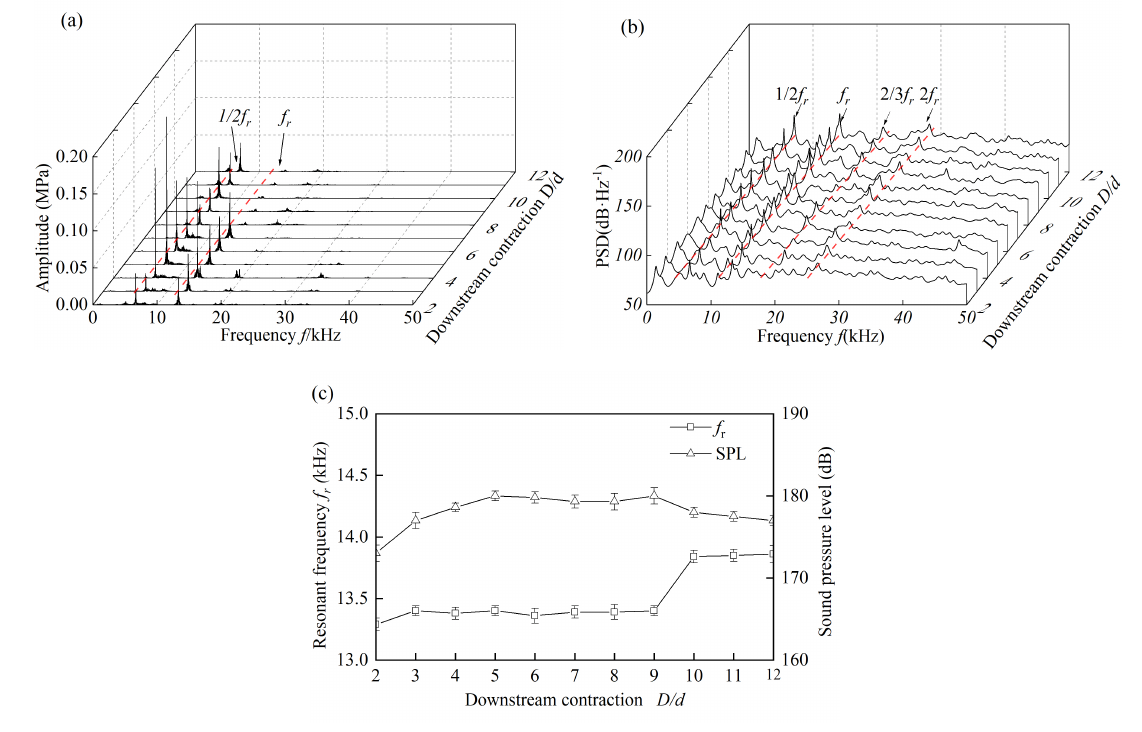
Figure 7. Frequency characteristics of self-excited waterjet as a function of downstream contraction ratio D / d . ( a ) Spectra of self-excited waterjet’s pressure fluctuation with D / d from 2 to 12; ( b ) power spectrum density of self-excited waterjet’s noise with D / d from 2 to 12; ( c ) resonance frequency and SPL as a function of downstream contraction ratio D / d .